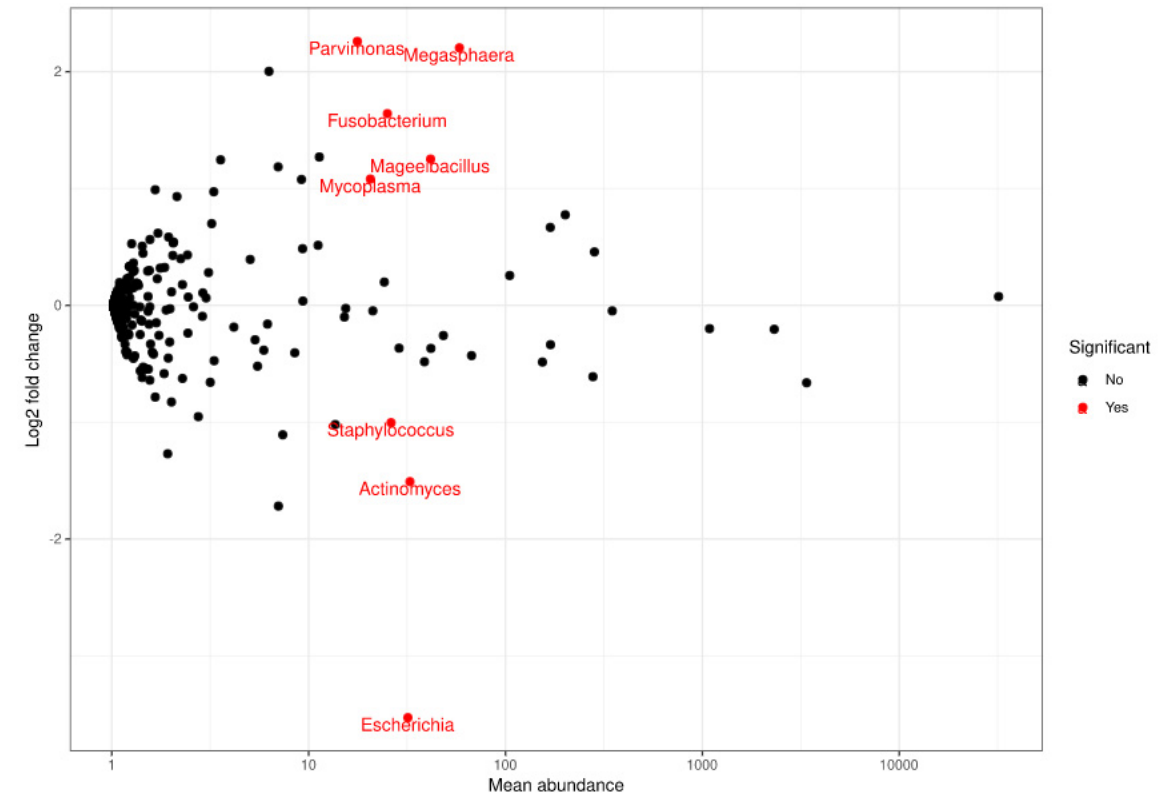
Figure 4. Representation of FoldChange values and computation of the sequences obtained when comparing populations at a genus level. Red dots: genera that significantly decreased (upper end) or increased (lower end) at the final visit based on the comparison performed using DESeq.